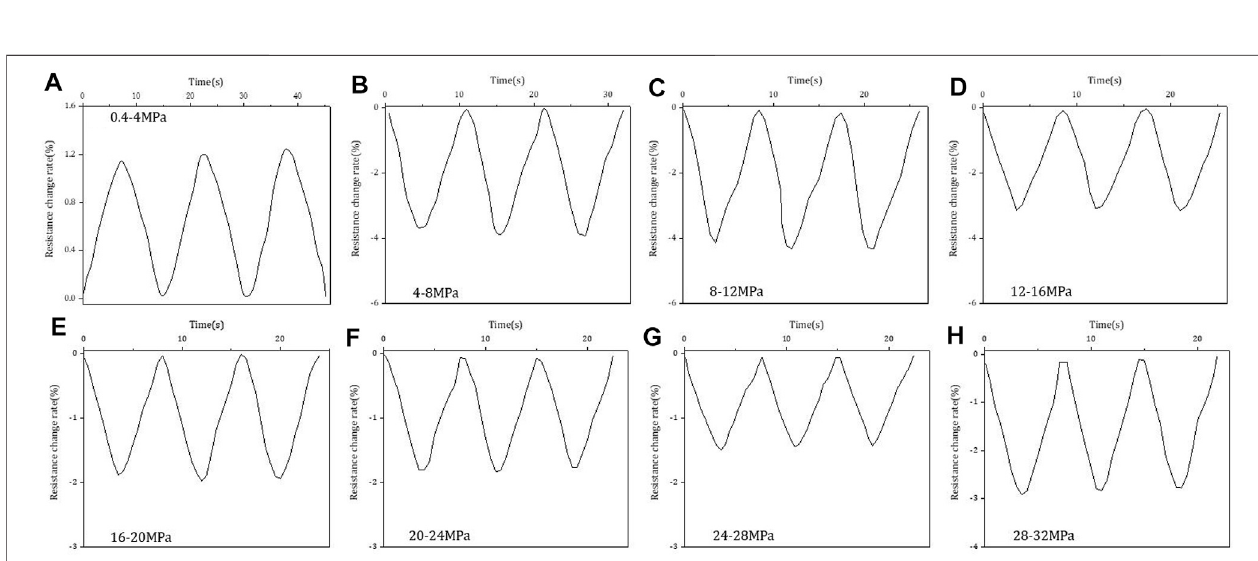
FIGURE 12| Resistance change rate-time diagram of sustained cyclic loading condition: (A) Cyclic stess: 0.4 – 4 MPa; (B) Cyclic stess: 4 – 8 MPa; (C) Cyclic stess: 8 – 12 MPa; (D) Cyclic stess: 12 – 16 MPa; (E) Cyclic stess: 16 – 20 MPa; (F) Cyclic stess: 20 – 24 MPa; (G) Cyclic stess: 24 – 28 MPa; (H) Cyclic stess: 28 – 32 MPa.